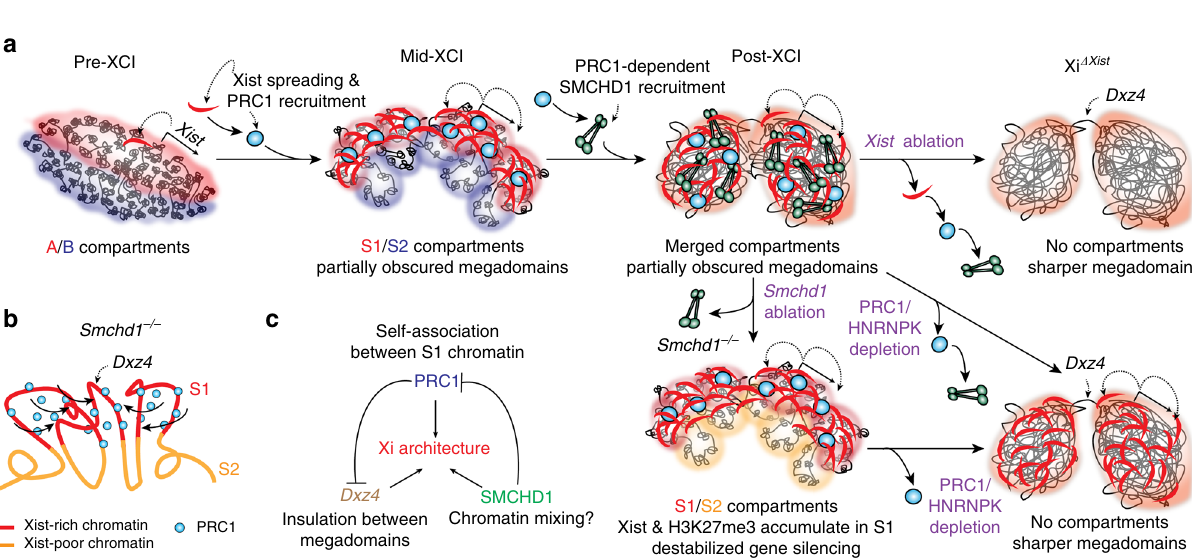
Fig. 8 A model for the folding and unfolding of the inactive X chromosome (Xi) origami. a Summary: A stepwise folding process for the transformation of the Xi ( “ Origami Model ” ). Xist RNA is produced from the A compartment. Following transcription, Xist initially spreads to co-segregated A-compartmental chromatin. Through recruiting polycomb repressive complex 1 (PRC1), Xist recon fi gures the Xi into S1/S2 compartments. Following structural maintenance of chromosomes hinge domain containing 1 (SMCHD1) recruitment (via a mechanism requiring heterogeneous nuclear ribonucleoprotein K (HNRNPK), PRC1, and H2AK119ub), S1/S2 compartments are merged to form a compartment-less structure. In cells losing SMCHD1 after completing XCI, S1/S2 compartments reappear, coinciding with accumulation of Xist, H3K27me3, and H2AK119ub in the S1 compartment and destabilized gene silencing. Depleting PRC1 or HNRNPK diminishes the reappeared S1/S2 compartments, resulting in a “ de-compartmentalized ” Xi with sharper partition between the two megadomains. In cells that have undergone Xist ablation post XCI, both SMCHD1 and PRC1 fail to be recruited to the Xi, also leading to a “ de- compartmentalized ” Xi with sharper megadomains. b Model: In the absence of SMCHD1, Xist-rich chromatin co-segregates, likely via PRC1 self- association, leading to the formation of S1/S2 compartments. The self-association between S1 chromatin creates long-range interaction across the Dxz4 boundary, thus partially obscuring megadomains. c Three major folding mechanisms that de fi ne the large-scale Xi architecture: self-association between Xist/H2AK119ub-enriched chromatin to form S1/S2 compartments through PRC1, potential chromatin mixing activity of SMCHD1, and inter-megadomain insulation by Dxz4 . When superimposed on the Xi, these folding mechanisms sometimes interfere with each other — SMCHD1 attenuates S1/S2 structure, and PRC1 obscures